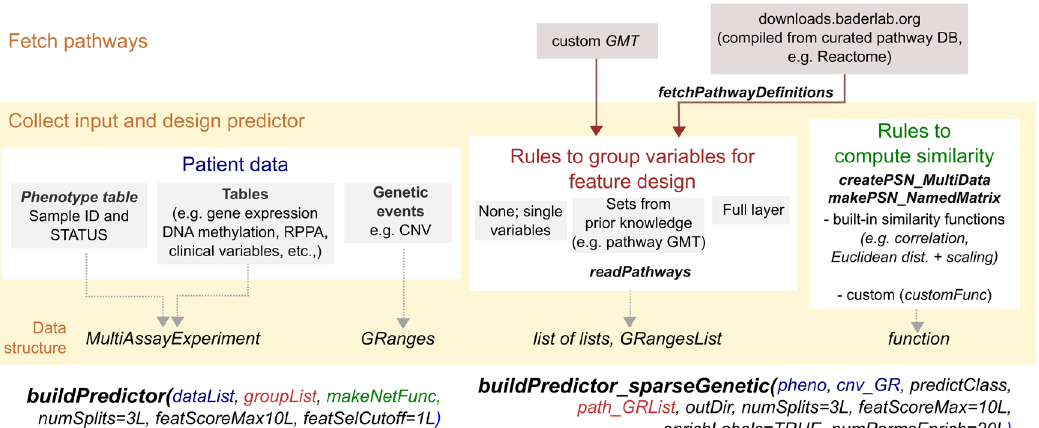
Figure 2. netDx software workflow. The yellow box shows data provided to netDx to build the predictor. See use cases for examples. Patient data is provided as a MultiAssayExperiment object, with the patient metadata in the colData slot. Variable grouping rules, used for feature design, are provided as a list of lists. The outer list corresponds to a given assay; each entry in the corresponding list corresponds to one group of measures and is used to create a single feature. For instance, in a pathway-based design, one entry in the outer list would be “gene expression”, with each inner list containing genes grouped by pathways. In this scenario, each of these gene groupings generates a single pathway-level feature. Pathway definitions can be automatically fetched using the fetchPathwayDefinitions() function, or custom definitions can be provided in the GMT file format. For the workflow using sparse genetic data (see Use Case 3 ), such as CNVs, patient CNVs are provided to netDx as a GRanges object. In this instance, pathways are provided in GRangesList